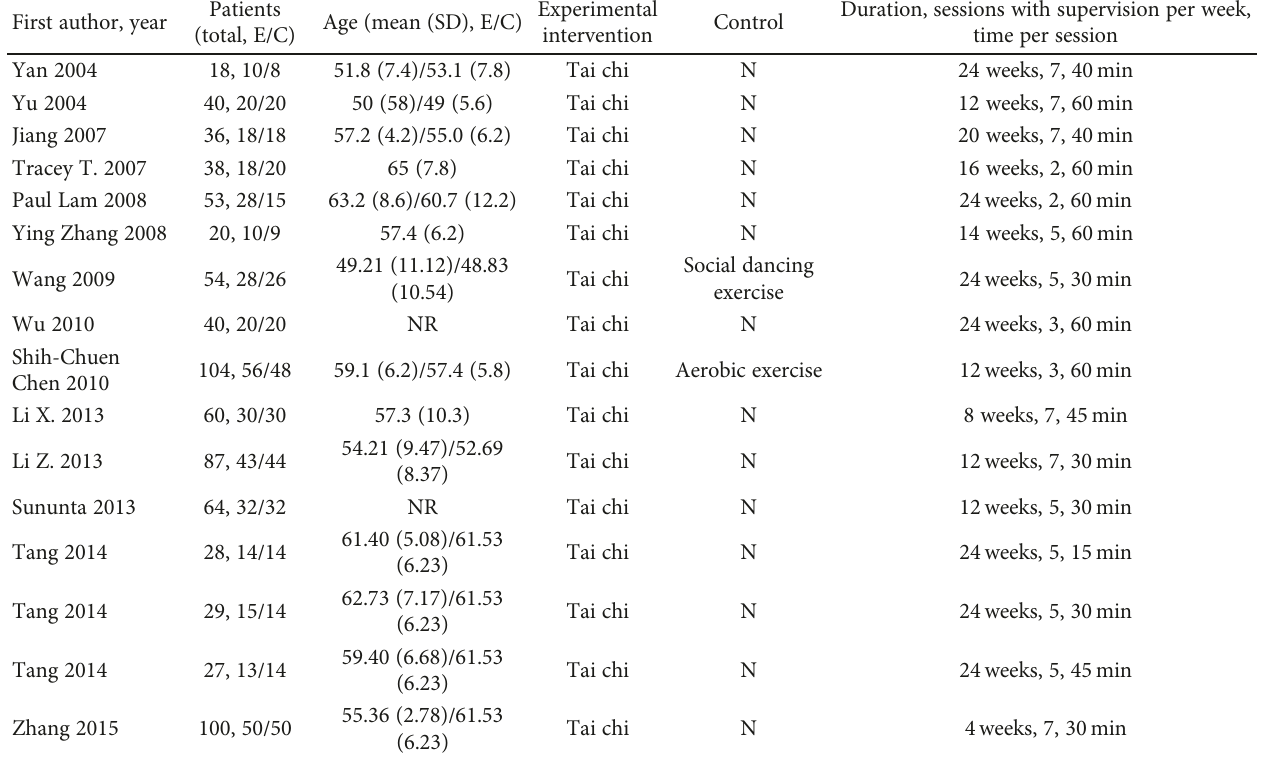
Table 1: Characteristics and quality assessments of the included